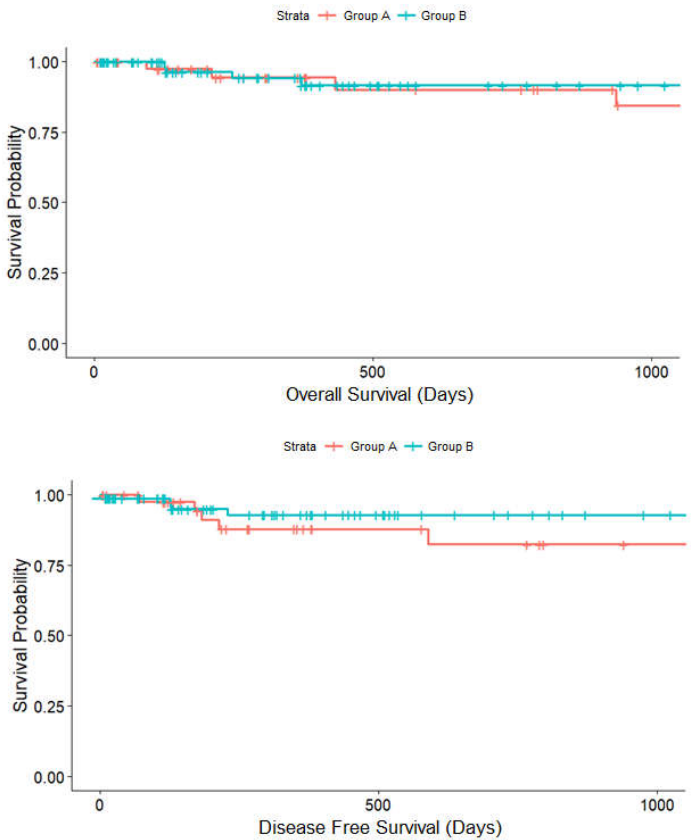
Figure 5. Kaplan–Meier analysis on the effect of surgical training group A (red line) and group B (blue line) on disease-free survival ( p = 0.111) and overall survival ( p = 0.787). Upon Cox regression analysis, the presence of SRCC ( p = 0,049 HR = 3.019 (1.003– 9.088)) or an R1 resection status ( p = 0.003 HR = 12.815 (2.350–69.871)) were significant factors negatively associated with DFS (Table 5). In contrast, overall survival was signifi- cantly affected by R1 resection status ( p = 0,024 HR = 19.103 (1.473–247.692)) and a pro- longed OT of >360 min ( p = 0.050 HR = 0.234 (0.055–1.000)). Table 5. Cox proportional hazard model for overall survival and disease-free survival. Disease Free Survival